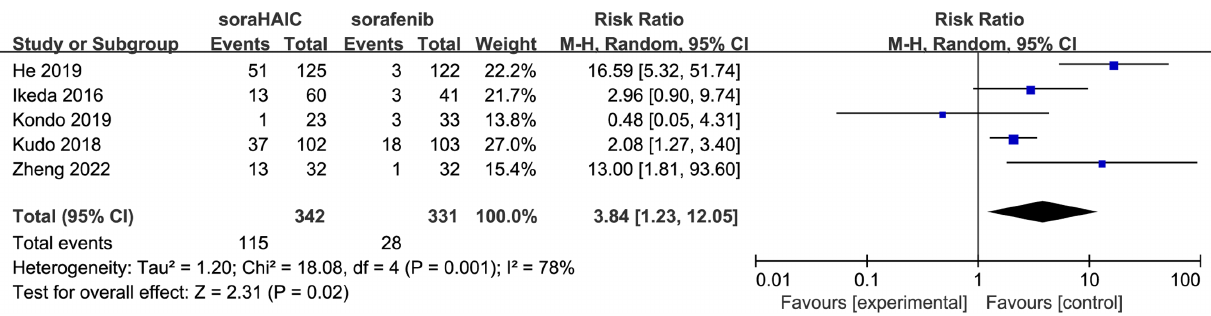
Figure 5. Forest plot comparing objective response rates between the SoraHAIC and sorafenib groups. SoraHAIC, sorafenib plus hepatic arterial infusion chemotherapy.